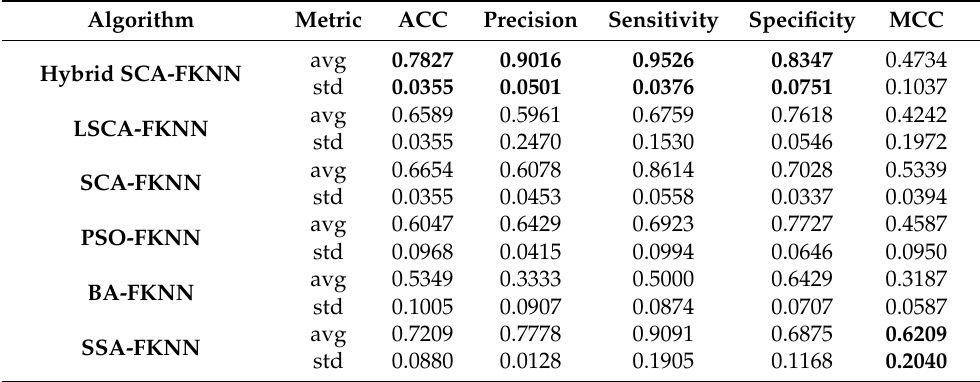
Table 10. Results of the hybrid-FKNN and comparison models on the glass dataset. (Bold indicates the best in comparison method).